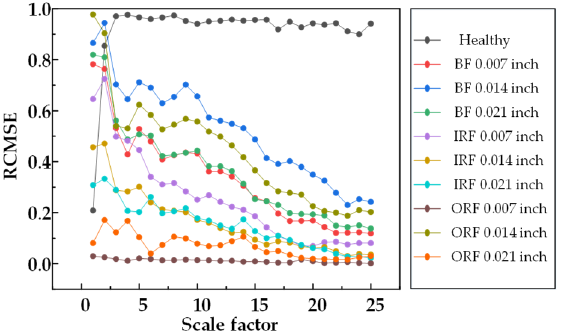
Figure 4. RCMSE entropy values of 25 scale factors under different damage degrees.